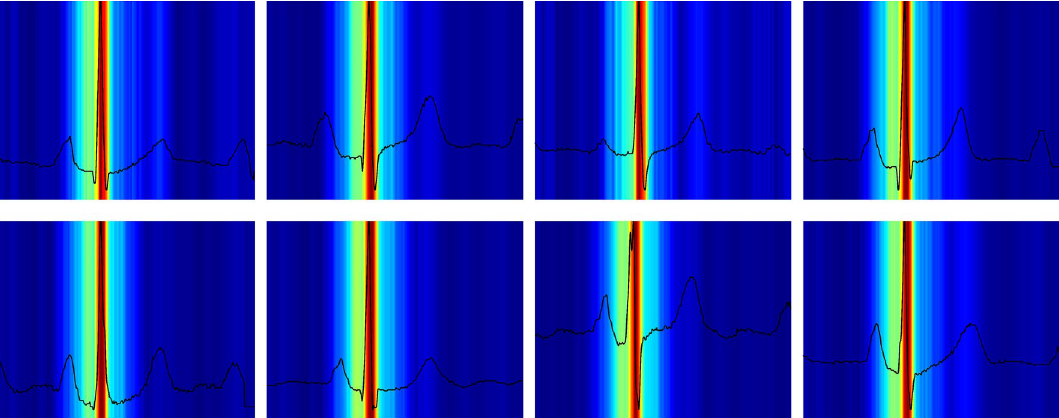
Figure 4. Visualizations of the attention maps from the sex classification model for eight different ECGs. The plots suggest that the QRS-complex and especially the downslope of the R-wave is most important when distinguishing between a male and female ECG. Red color indicates high importance and blue color low importance of the ECG for the decision of the neural network.